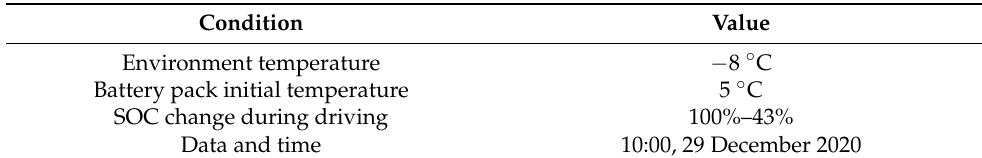
Table 1. Basic information of the data to validate the model.